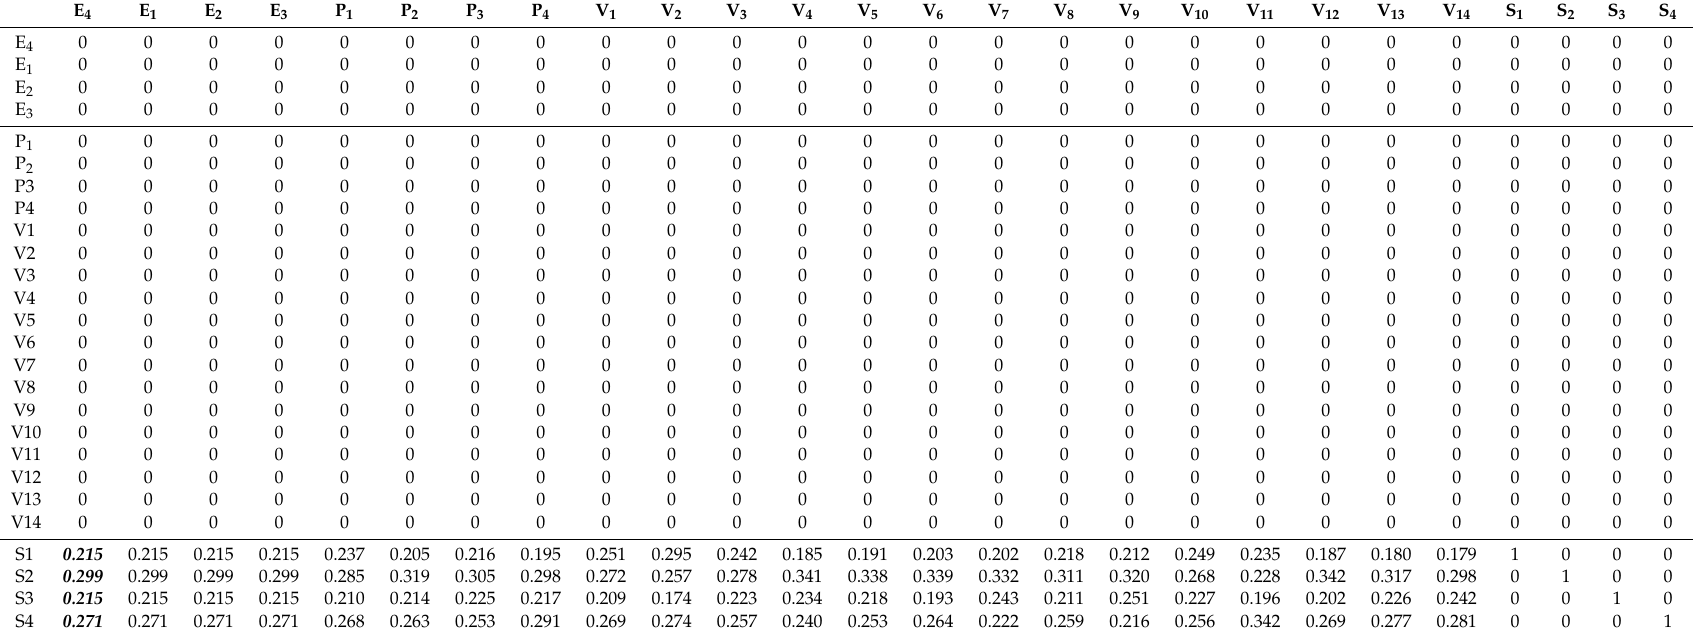
Table 9. Weighted supermatrices and limit